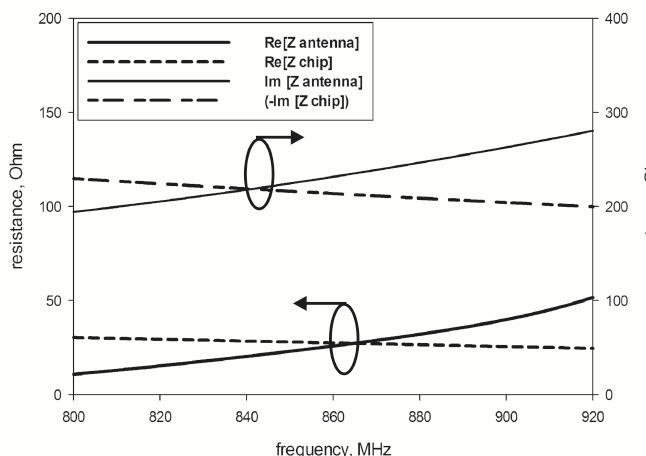
Figure 2: Variations of the real and imaginary